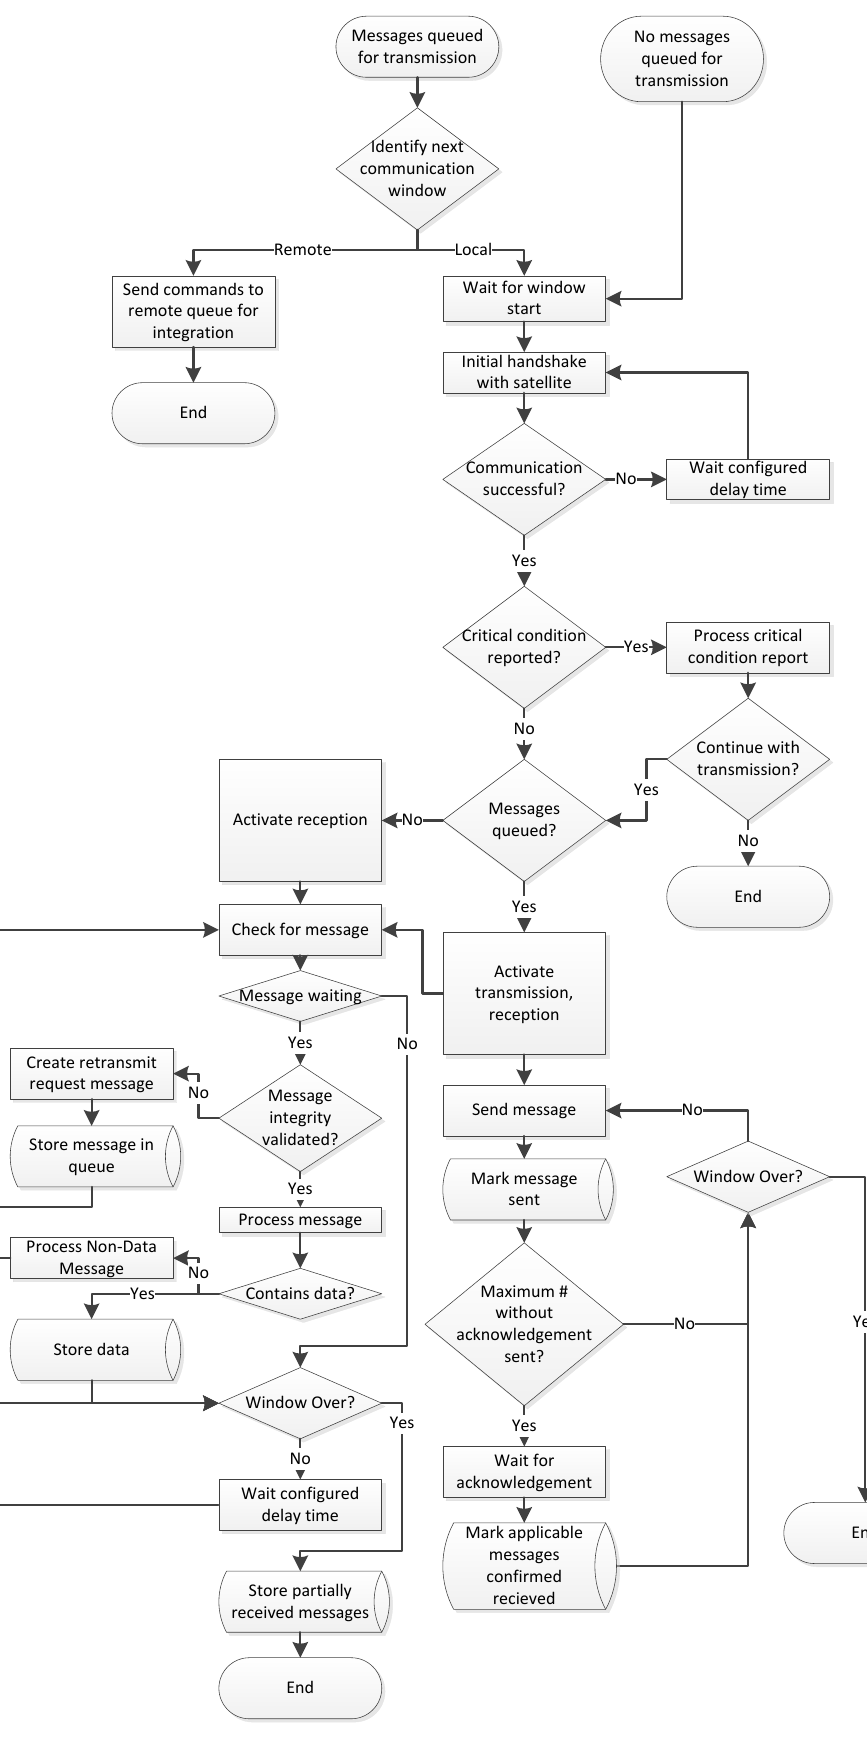
Figure 6. Ground Station Communications